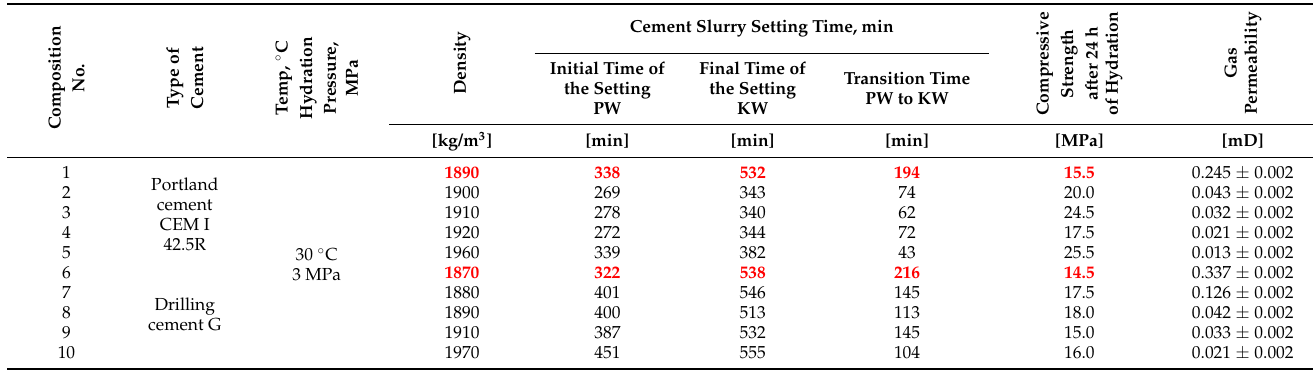
Table 2. Parameters of the tested cement slurrie.